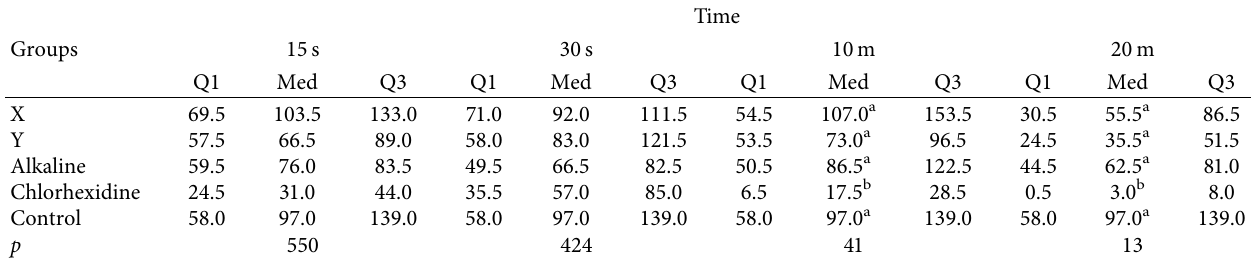
Figure 1: Percentage of the tested substances cell viability within 15seconds and 30 seconds; there was no significant difference. However, it is observed that the lowest cell viability was of CLX at 2%; 10 and 20 minutes, with the test emulsions being similar to the control group, end the CLX at 2% different from the others. Table 1: Comparison of medians of viable cells in relation to groups according to